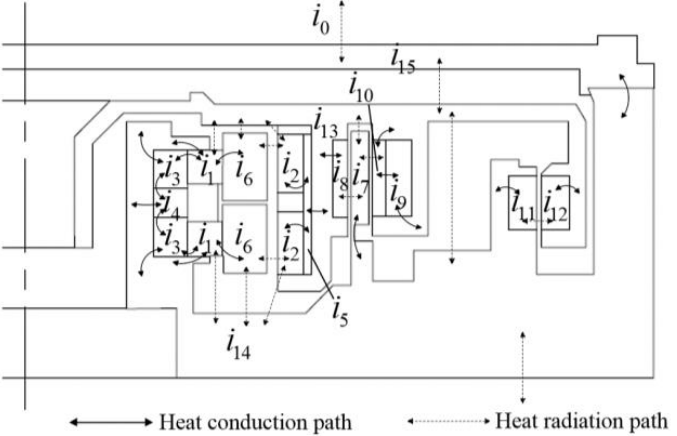
Figure 18. Equivalent node unit and heat dissipation path of MLRW. Then, the heat transfer relationship of each node unit can be expressed as the equiva- lent thermal network model, as shown in Figure